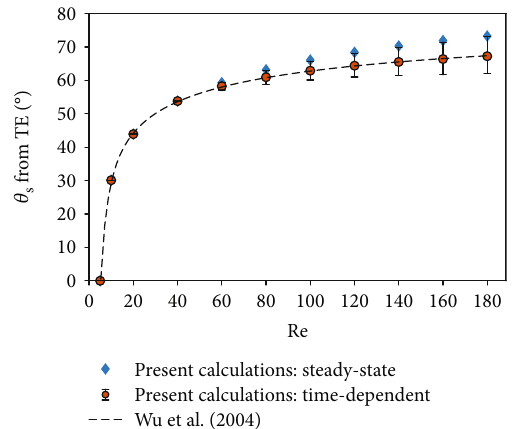
Figure 4: Validation results for both time-dependent and steady- state